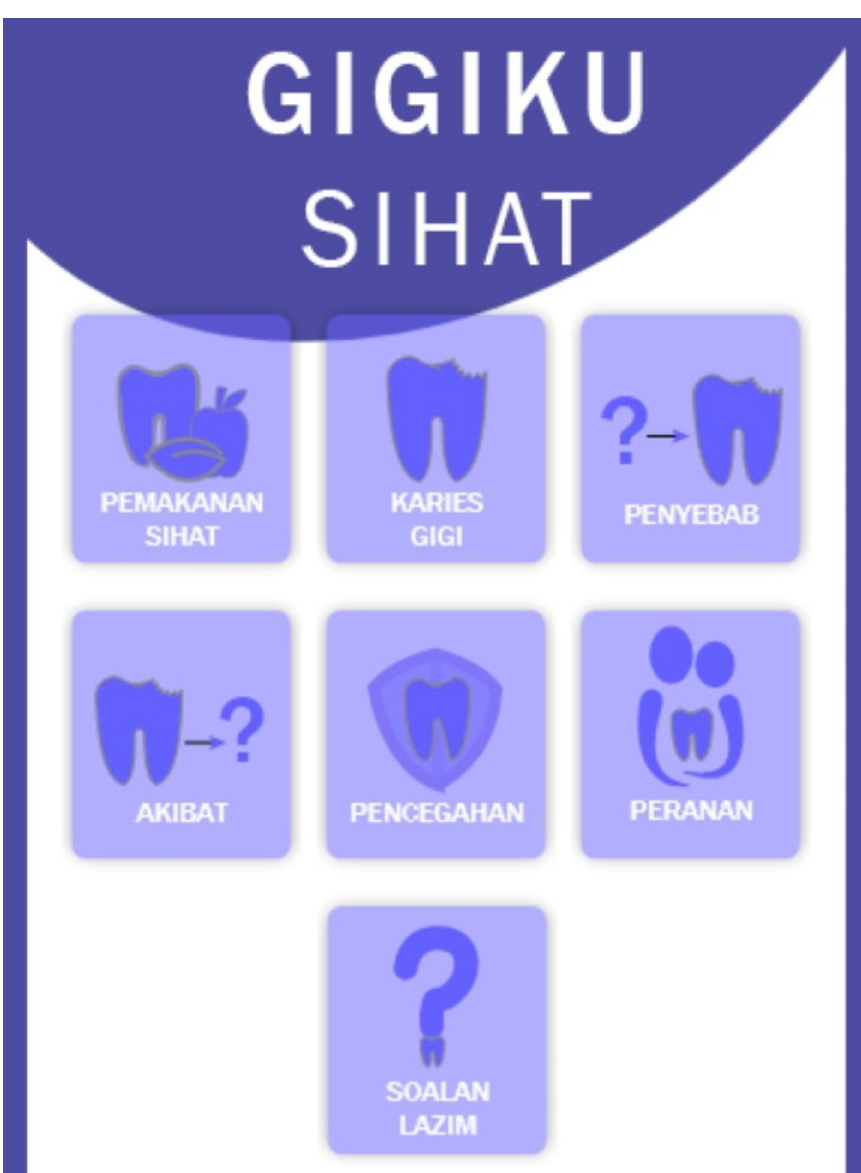
Fig 3. Adobe XD final design wireframe. Retrieved from https://xd.adobe.com/view/c2db4446-ddd7-4a6b-